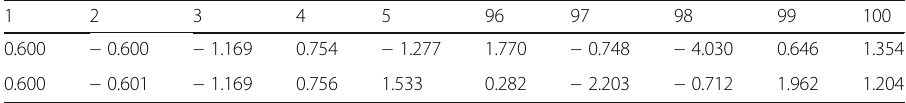
Table 1 The difference of production decision-making caused by the change of consumption demand x 1